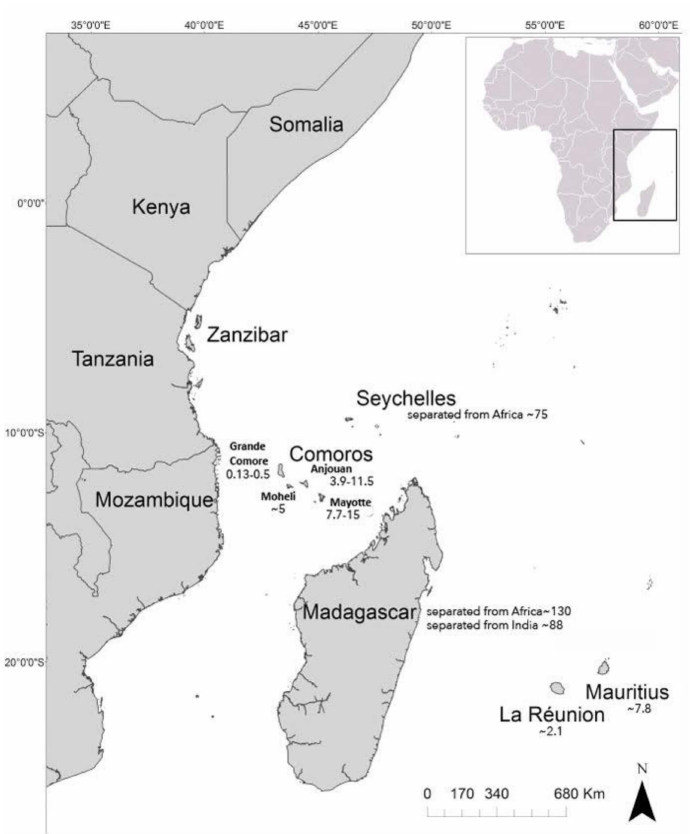
Figure 7. Map showing the date (in Mya) of separation and formation of the SWOI islands adapted from Warren et al., 2003